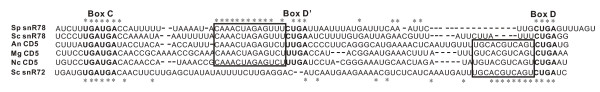
Alignment of homologous snoRNAs from three multicellular fungi and two yeasts. Conserved box elements are bold and boxed regions denote antisense elements. Stars indicate conserved nucleotides. Sp, S. pombe; Sc, S. cerevisiae; An, Aspergillus niger; Mg, Magnaporthe grisea; Nc, N. crassa .